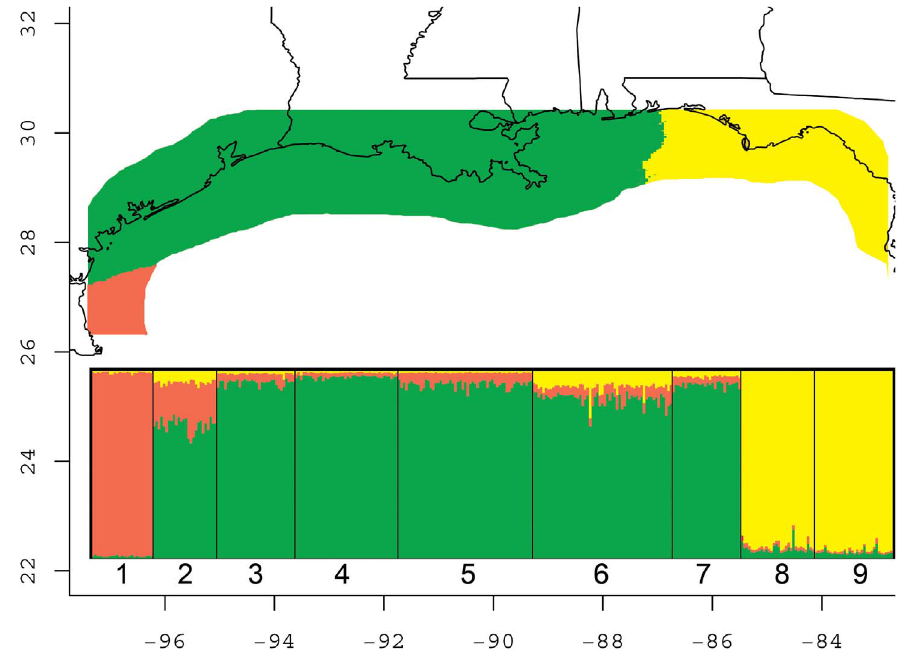
Figure 4. Graphical output of G ENE L AND (map) and S TRUCTURE (inset) analyses for best K =3 along the coast of the Gulf of Mexico. Numbers below S TRUCTURE output correspond to the nine sampled populations of Seaside Sparrow (see Fig. 1). G ENE L AND output has been cropped to remove much of the area (Gulf of Mexico) not occupied by Seaside Sparrows. Note that no birds were sampled from the western Florida panhandle, and no population assignment for birds in this area is possible based on our data. Axes (latitude and longitude) are only relevant to G ENE L AND